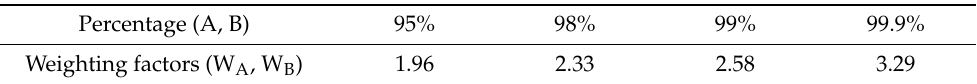
Table 1. Proportionality constants that correspond to a certain coverage of the PTV.